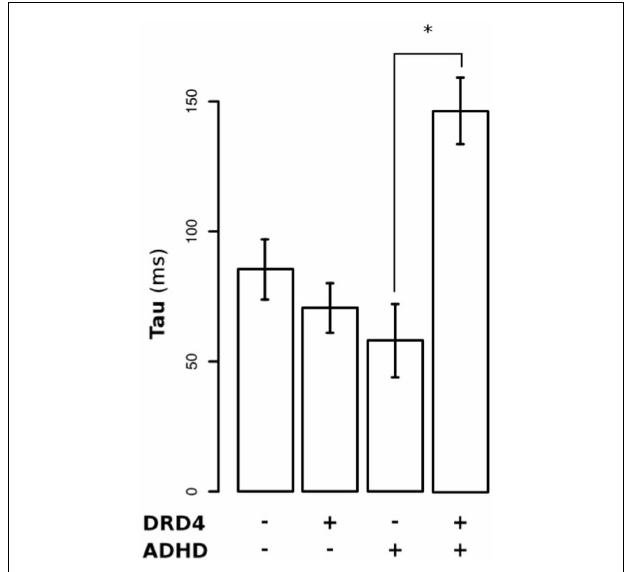
The Go–NoGo task used in this study demands high levels of executive/inhibition control due to extended task duration (about 8 min), low probability for the NoGo stimuli (10%), and shot inter-stimuli interval (1000 ms). In these conditions, the µ and σ components obtained after fitting ex-Gaussian curves on